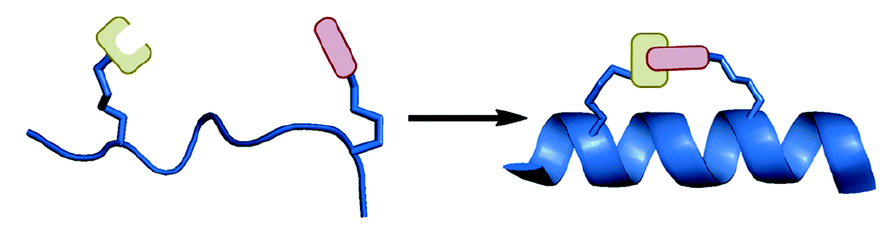
Scheme 1. Example of peptide stapling